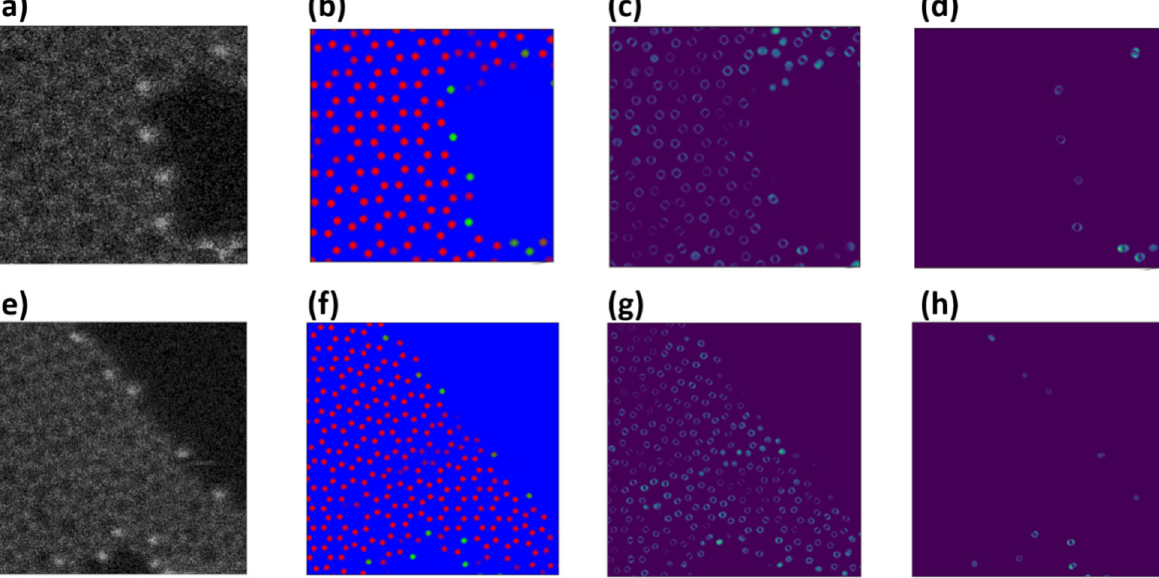
Fig. 5 Estimation of uncertainty in ensemble predictions on the level of individual pixels. a , e Experimental sub-images from frames 95 and 90. b , f Mean ensemble prediction. ( c , g ) and ( d , h ) show normalized uncertainty maps calculated as a standard deviation of ensemble predictions in each pixel for graphene atoms ( c , g ) and impurity atoms ( d , h ). See the accompanying notebook for uncertainty maps on the full images. The higher intensity in color in ( c , d ) and ( g , h ) correspond to higher uncertainty associated with the atoms identi fi ed in those speci fi c locations.